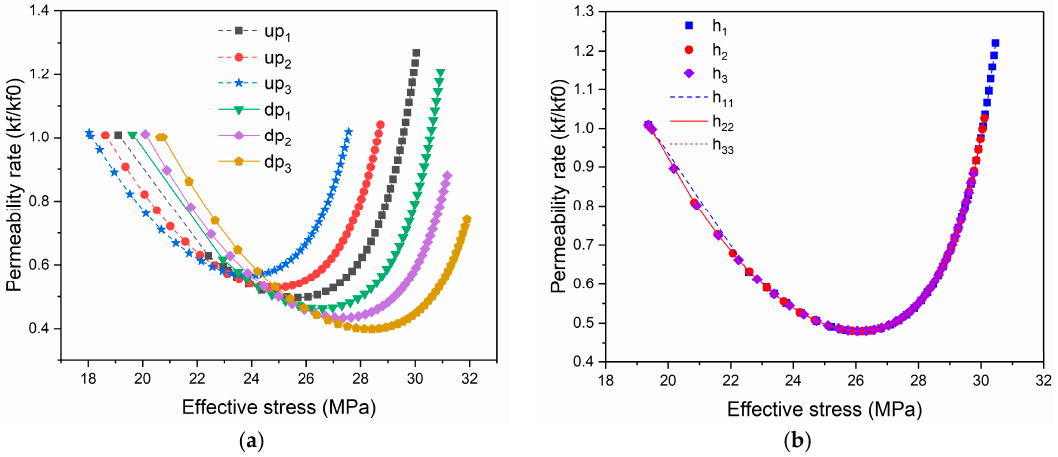
Figure 12. Relationship between the effective stress and the permeability: ( a ) Points located on line AB (along the dip of the reservoir), ( b ) points located on line CD (along the strike).